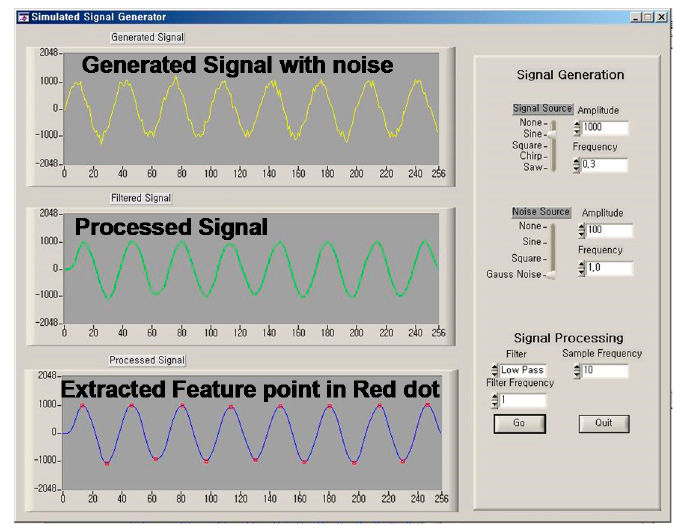
Figure 13. Screenshot of the simulated signal generator program for evaluating the feature point extraction.